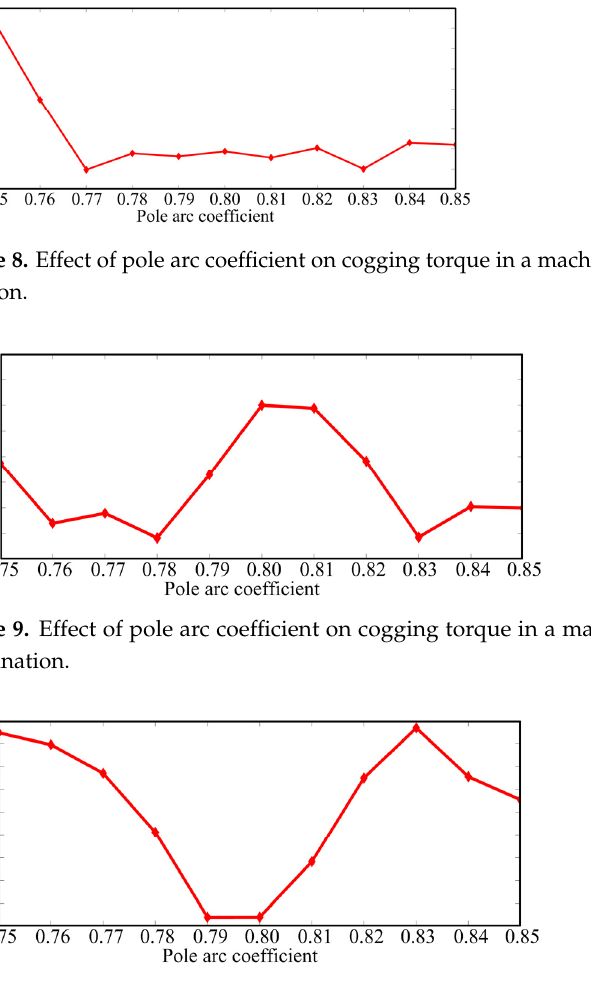
Figure 10. Effect of pole arc coefficient on cogging torque in a machine with a 10-pole and 21-slot combination.